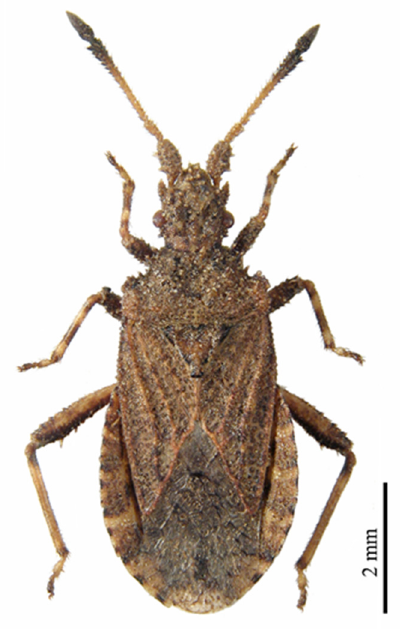
Figure 6. Arenocoris waltlii (Herrich-Schäffer 1834; photo M. Zilioli).